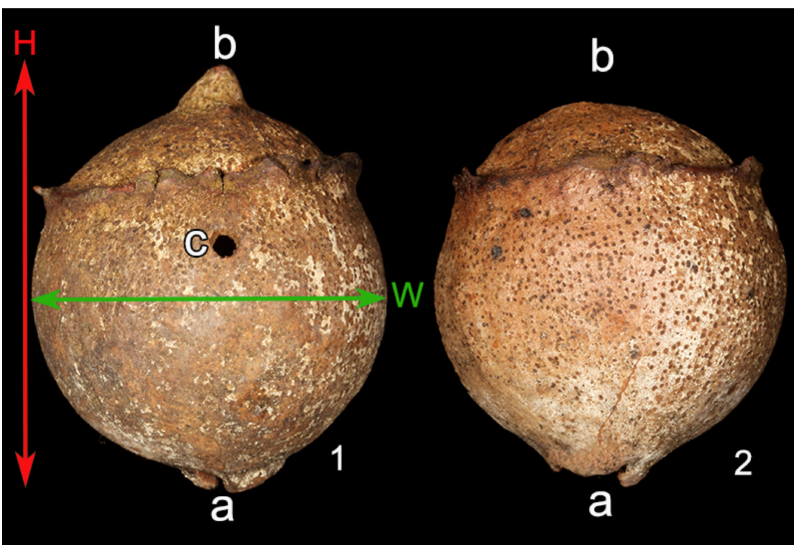
Figure 1. Linear dimensions measured on the gall and cutting procedure. The vertical line (H) shows Height measured as the distance between the insertion point of the gall on the tree branch (a) and the opposite peak (b). The horizontal line (W) shows the width, measured as the longest perpendicular line to the height. Each gall was divided into two halves (1,2) according to the height line (H), keeping the galler’s hole (c) in the middle of one of the